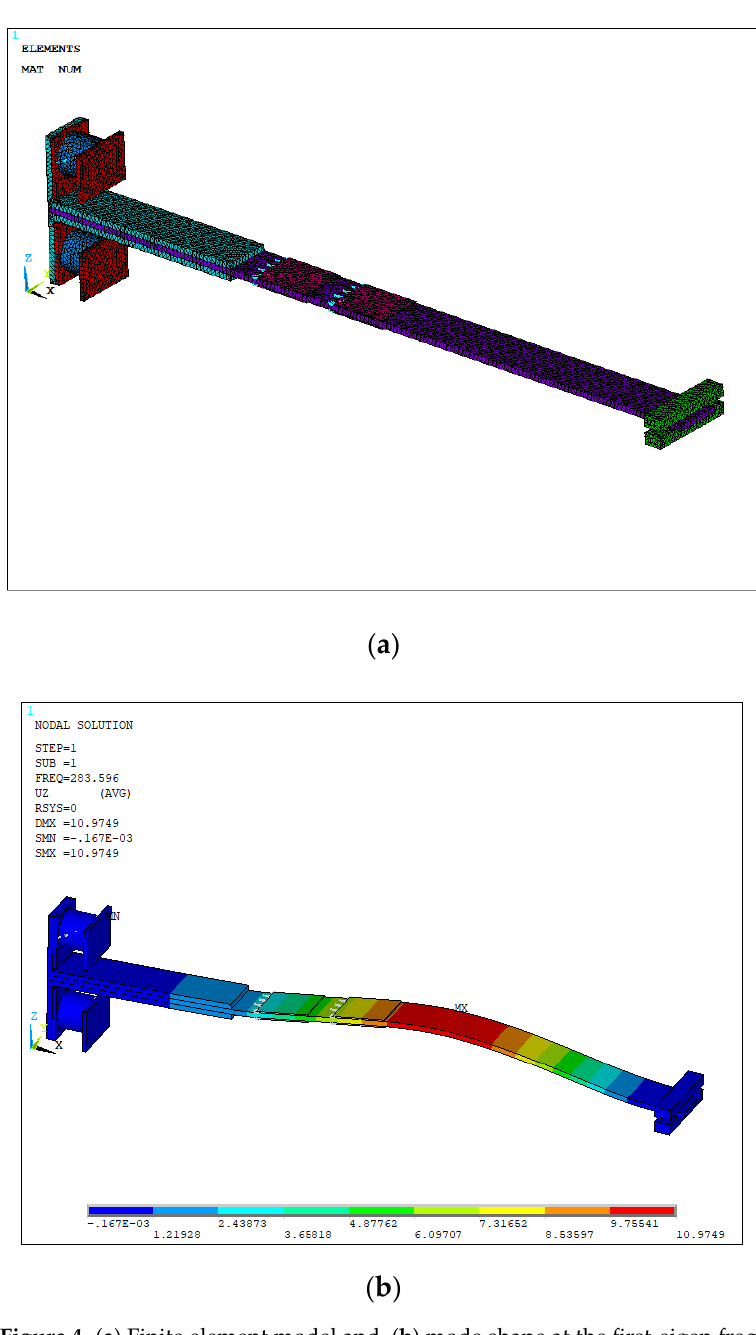
Figure 4. ( a ) Finite element model and, ( b ) mode shape at the first ‐ eigen frequency.